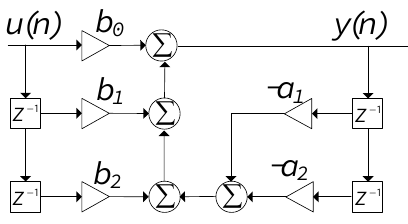
Figure 12. Digital implementation diagram of controller.